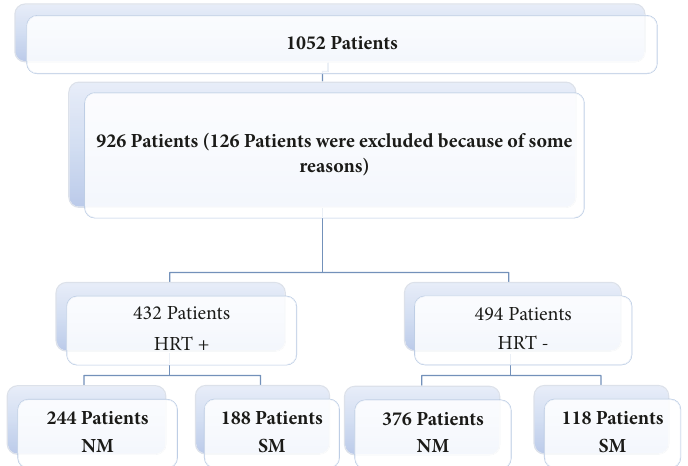
Figure 1: Patient selection and total workgroup distribution scheme. NM: natural menopause, SM: surgical menopause, and HRT: hormone replacement